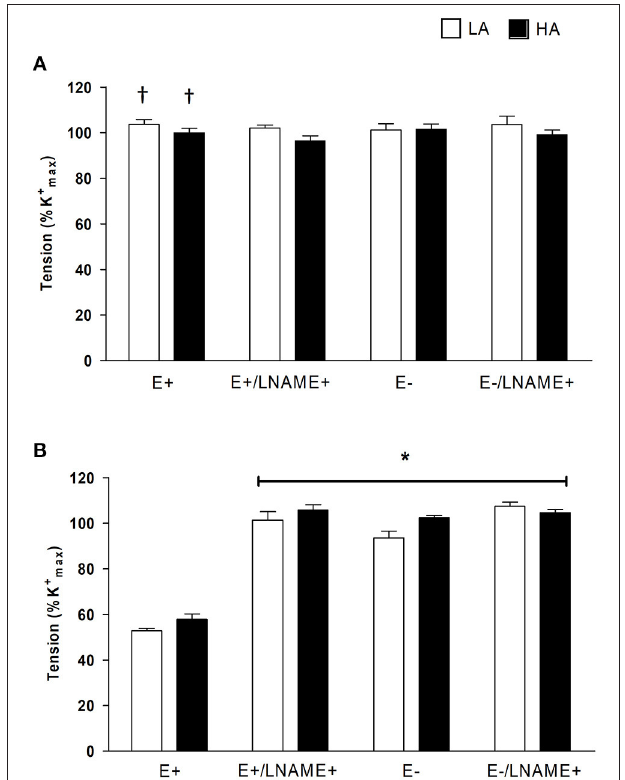
FIGURE 1 | Effect of N G-nitro- L -arginine methyl ester L-NAME and endothelium remove (–E) on PHE-induced contraction. (A) In NBLL ( n = 6) and CRC to PHE, and PHE after 30min of incubation with 10 − 5 M L-NAME with endothelium ( + E) and without endothelium (–E). (B) Effect of L-NAME on PHE-induced contraction in NBSH ( n = 6) and CRC to PHE, and PHE after 30min of incubation with 10 − 5 M L-NAME with endothelium ( + E) and without endothelium (–E), where open bar represent LA and close bar represent HA. Values are expressed as means ± SEM. Asterisk ( * ) represent a significant difference between NBSH (LA/HA) PHE-induce contraction ( + E) vs PHE-induce contraction ( + E) plus L-NAME and PHE-induce contraction (–E) (